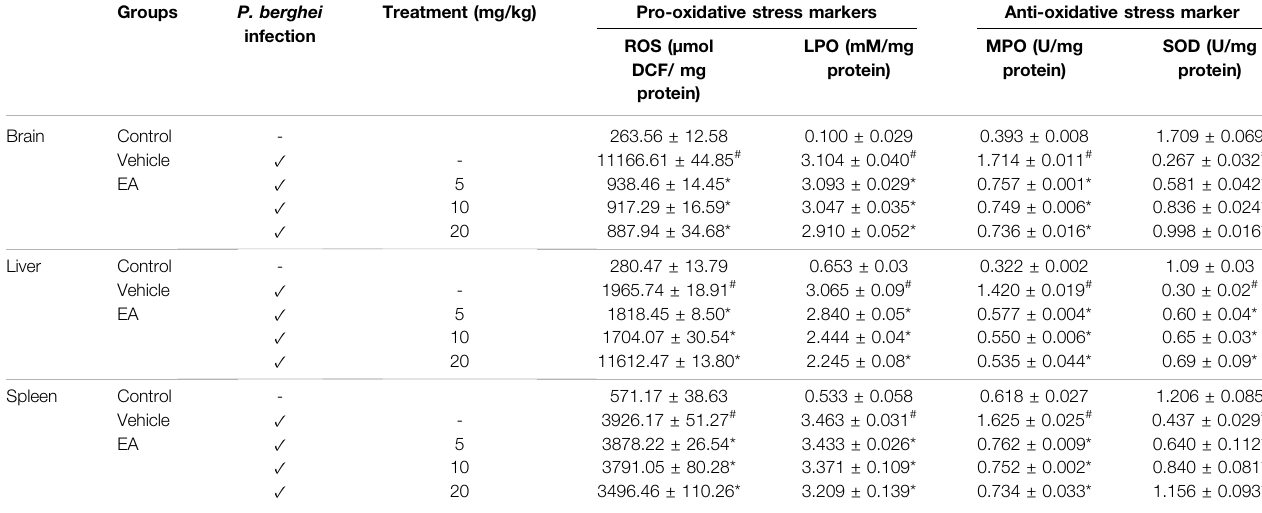
TABLE 1 | Effect of EA on oxidative and antioxidant stress marker levels in major organs affected by malaria infection. Data are expressed as mean ± SEM; P < 0.05 considered statistically signi fi cant; *vehicle vs treatment group; # control vs vehicle group; n (cid:1) 4.